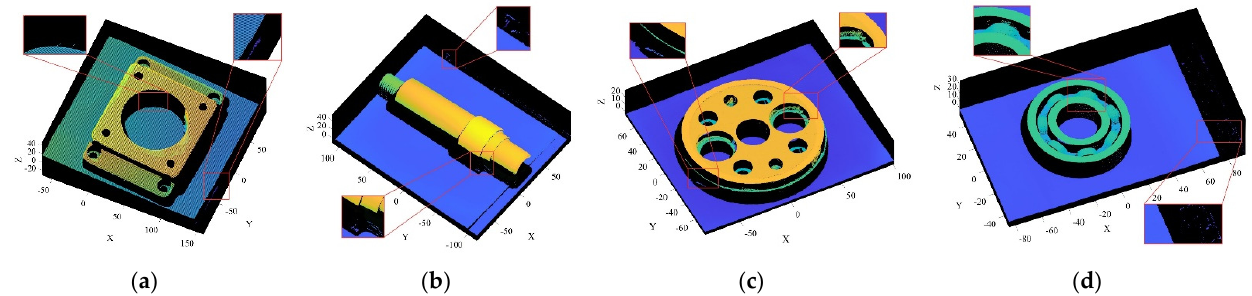
Figure 12. Denoising results for NLD algorithm: ( a ) object 1; ( b ) object 2; ( c ) object 3; ( d ) object 4.